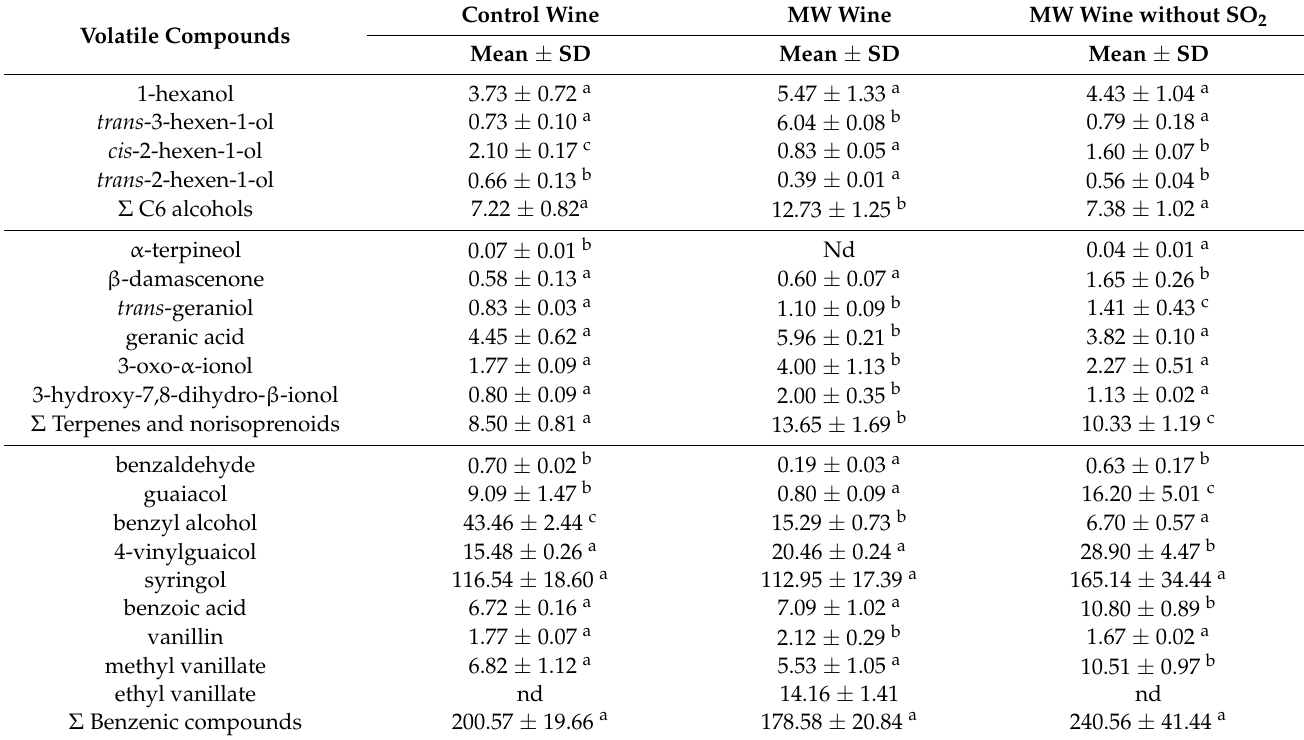
Table 2. Glycosidically bound volatile compound concentrations ( µ g/L) in control wines and those obtained from microwave-treated grapes elaborated with and without SO 2 ( n =